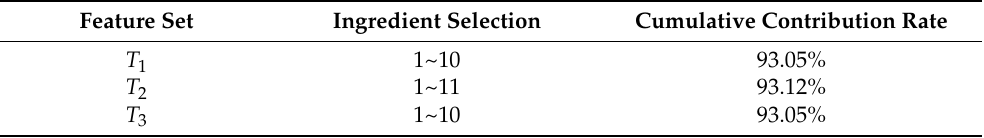
Table 5. PCA dimensionality reduction